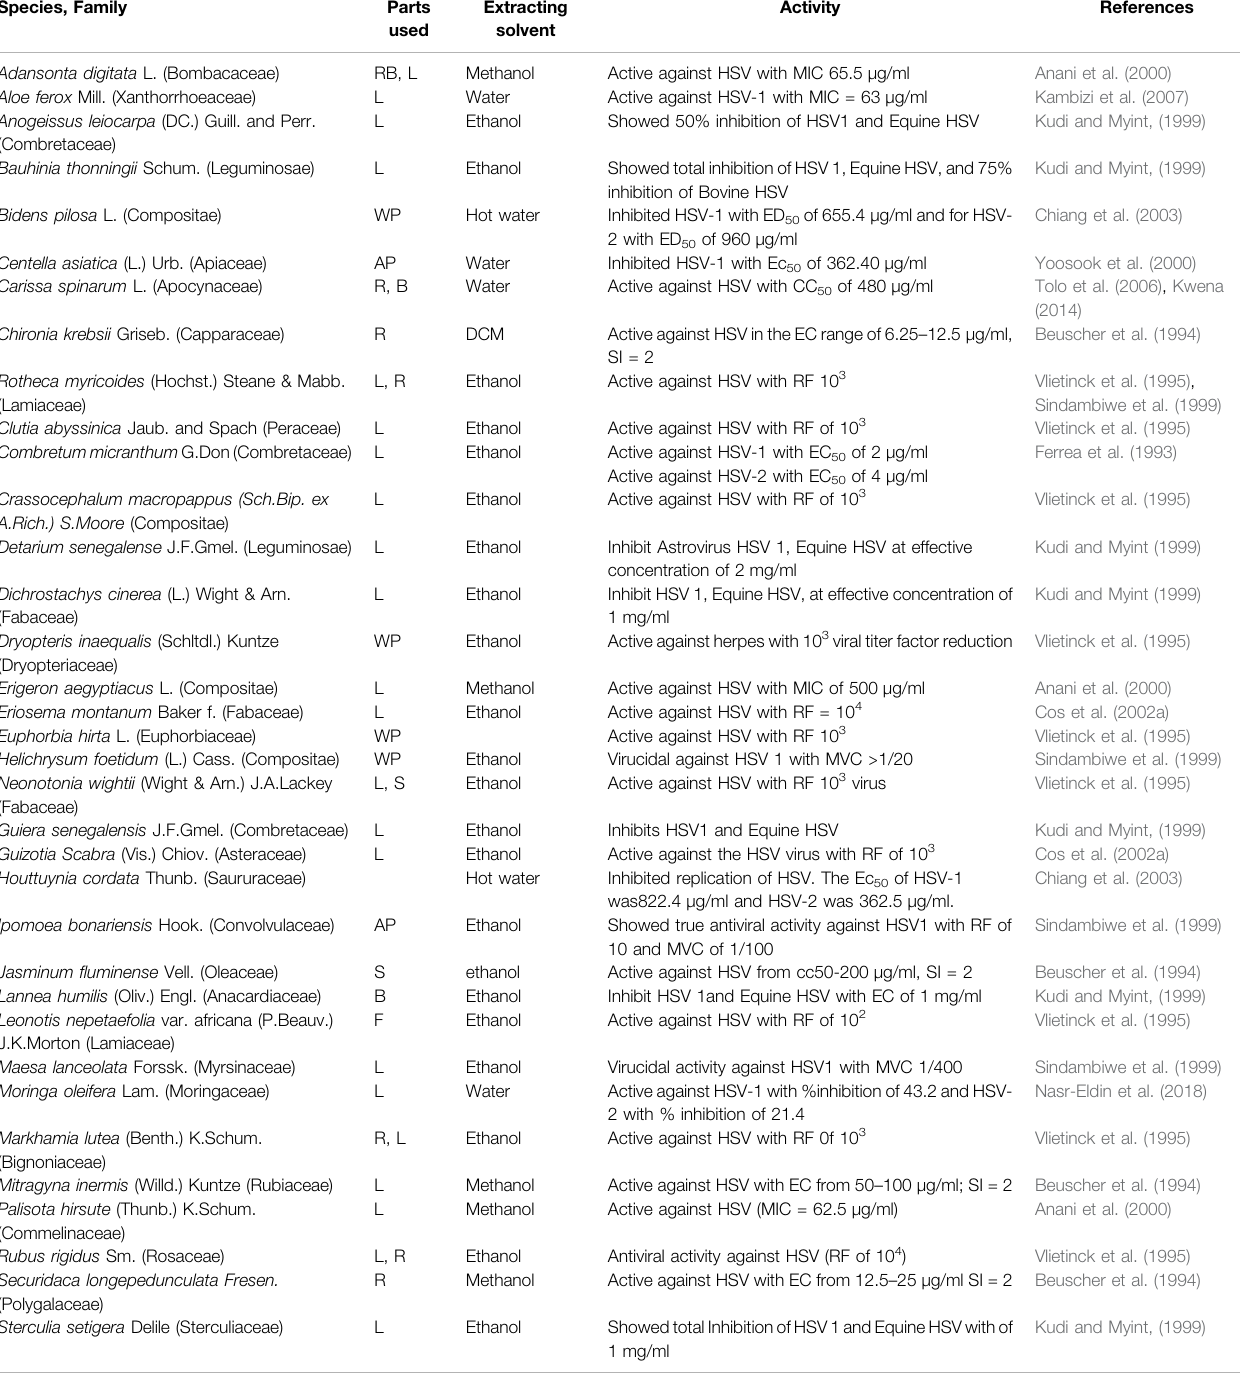
TABLE 3 | Antiviral activity of African medicinal plants against Herpes simplex virus. Species,